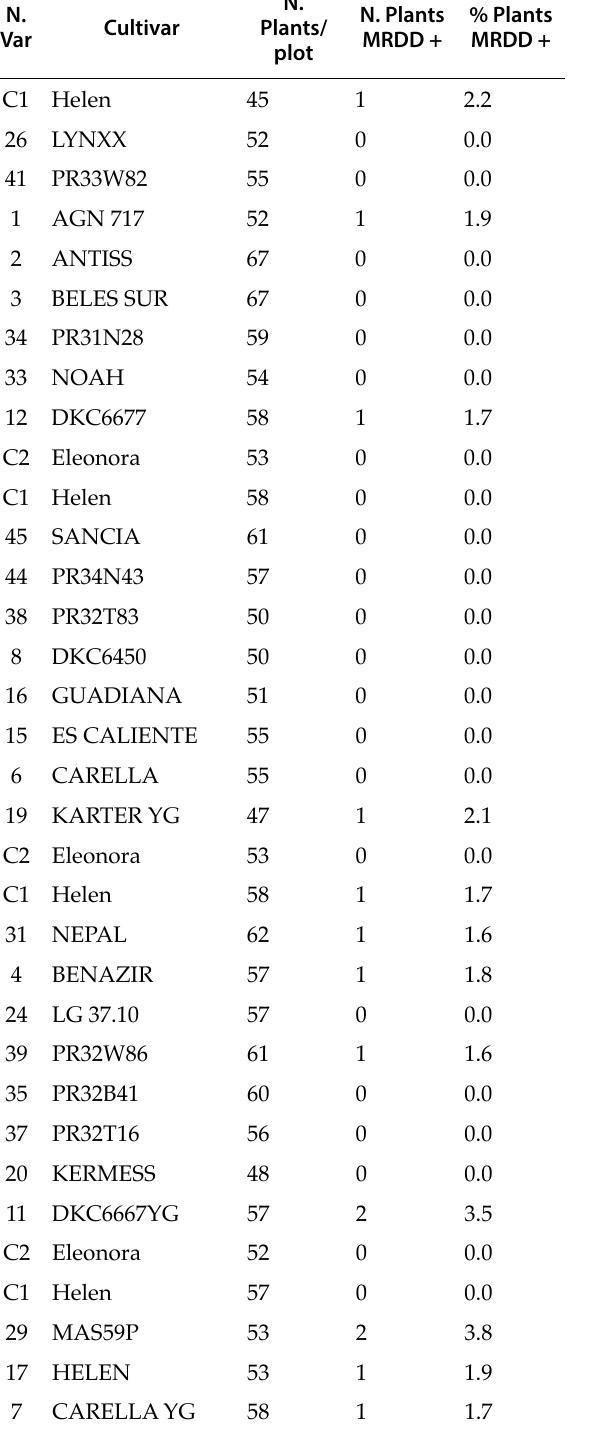
Table 2. Incidence of maize genotypes plants showing Maize rough dwarf disease (MRDD) in the locality of Poal, Spain. N. Cultivar Var